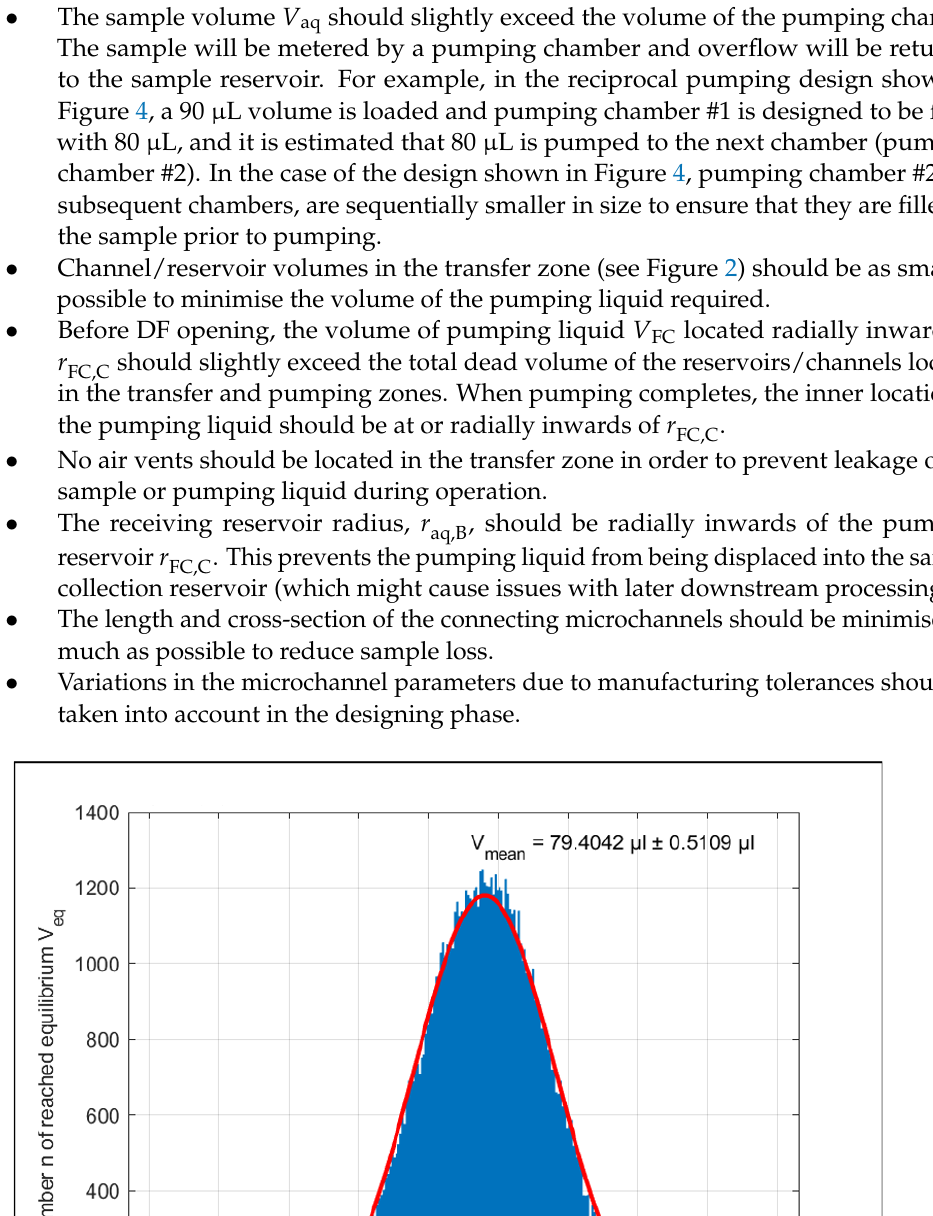
Figure 4. Multi-step reciprocating pumping is demonstrated using coloured water and FC-40. The organic-based FC-40 is prevented from entering the pumping chamber from the underside by the water-specific DFs. Hidden connecting channels are illustrated by dashed yellow lines. The sample is loaded and the disc is rotated at 30 Hz. Pumping chamber #1 fills with dyed water and wets the DF from the topside. Due to its higher density, the released FC-40 flows underneath the coloured